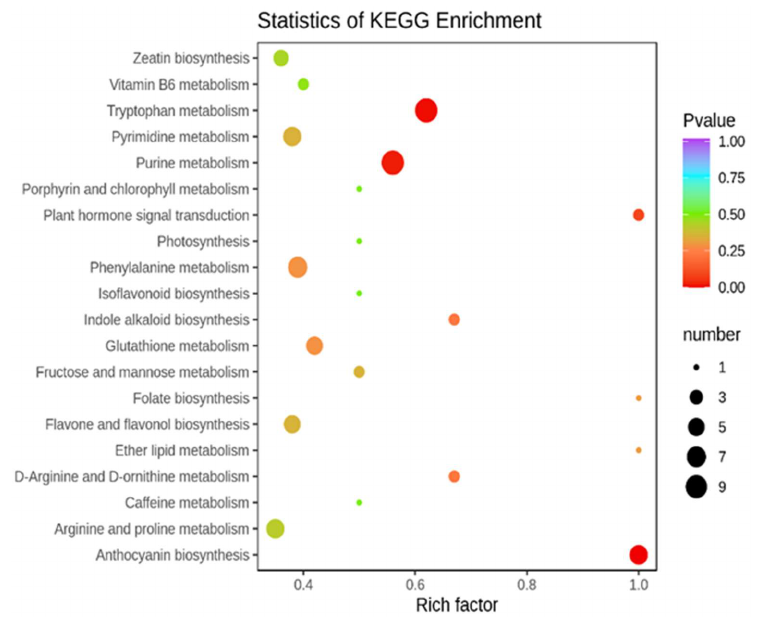
Figure 4. DAMs KEGG pathway enrichment between CK and T1.